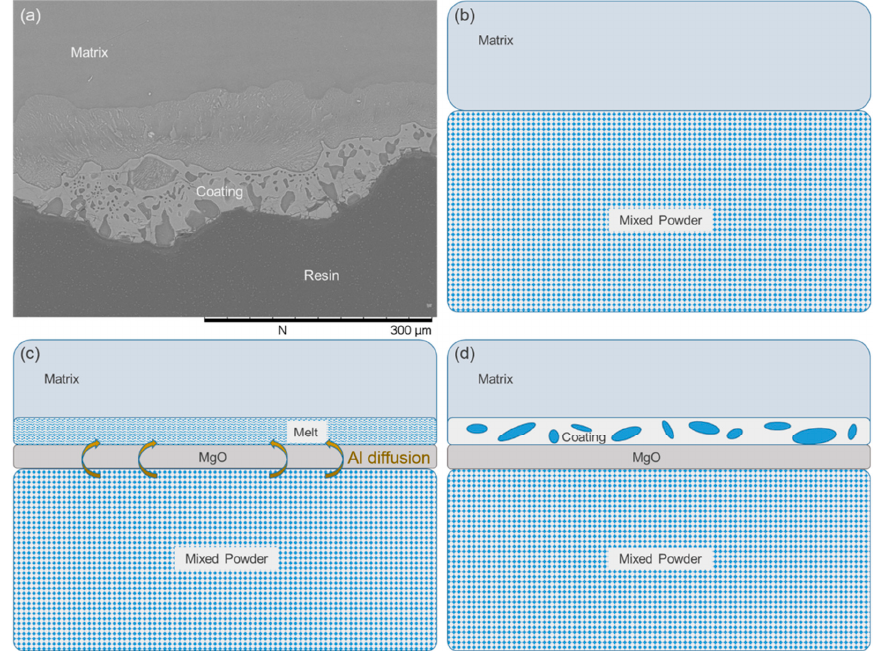
2 Figure 2. The microphotograph of the as-fabricated coating ( a ) and schematic diagrams to illustrate the formation process of the coating ( b – d ).